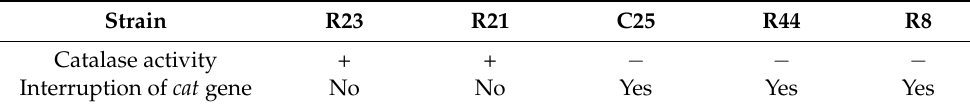
Table 1. Comparison of the catalase activity of different T. halophilus strains.